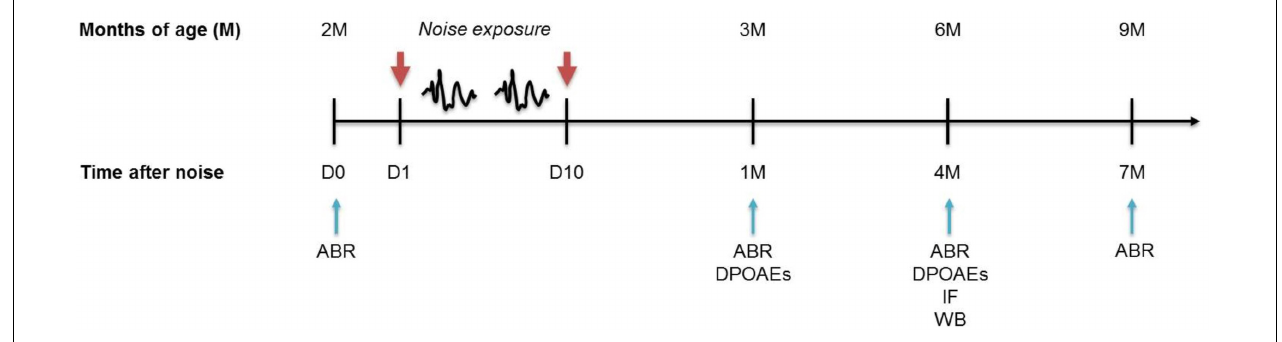
FIGURE 1 | Experimental design and time schedule. Mice of 2 months of age (M) at the beginning of the study were used. Baseline hearing thresholds were evaluated the day before (D0) the exposure to repeated noise sessions lasting 10 consecutive days (D1 - D10). After 1, 4, and 7 months from trauma sessions, when the mice were aged 3, 6, and 9 M, the functional (ABR and DPOAEs) and/or molecular (WB/IF) evaluations were performed. ABRs, auditory brainstem responses; DPOAEs, distortion products otoacoustic emissions; IF, immunofluorescence; WB, western